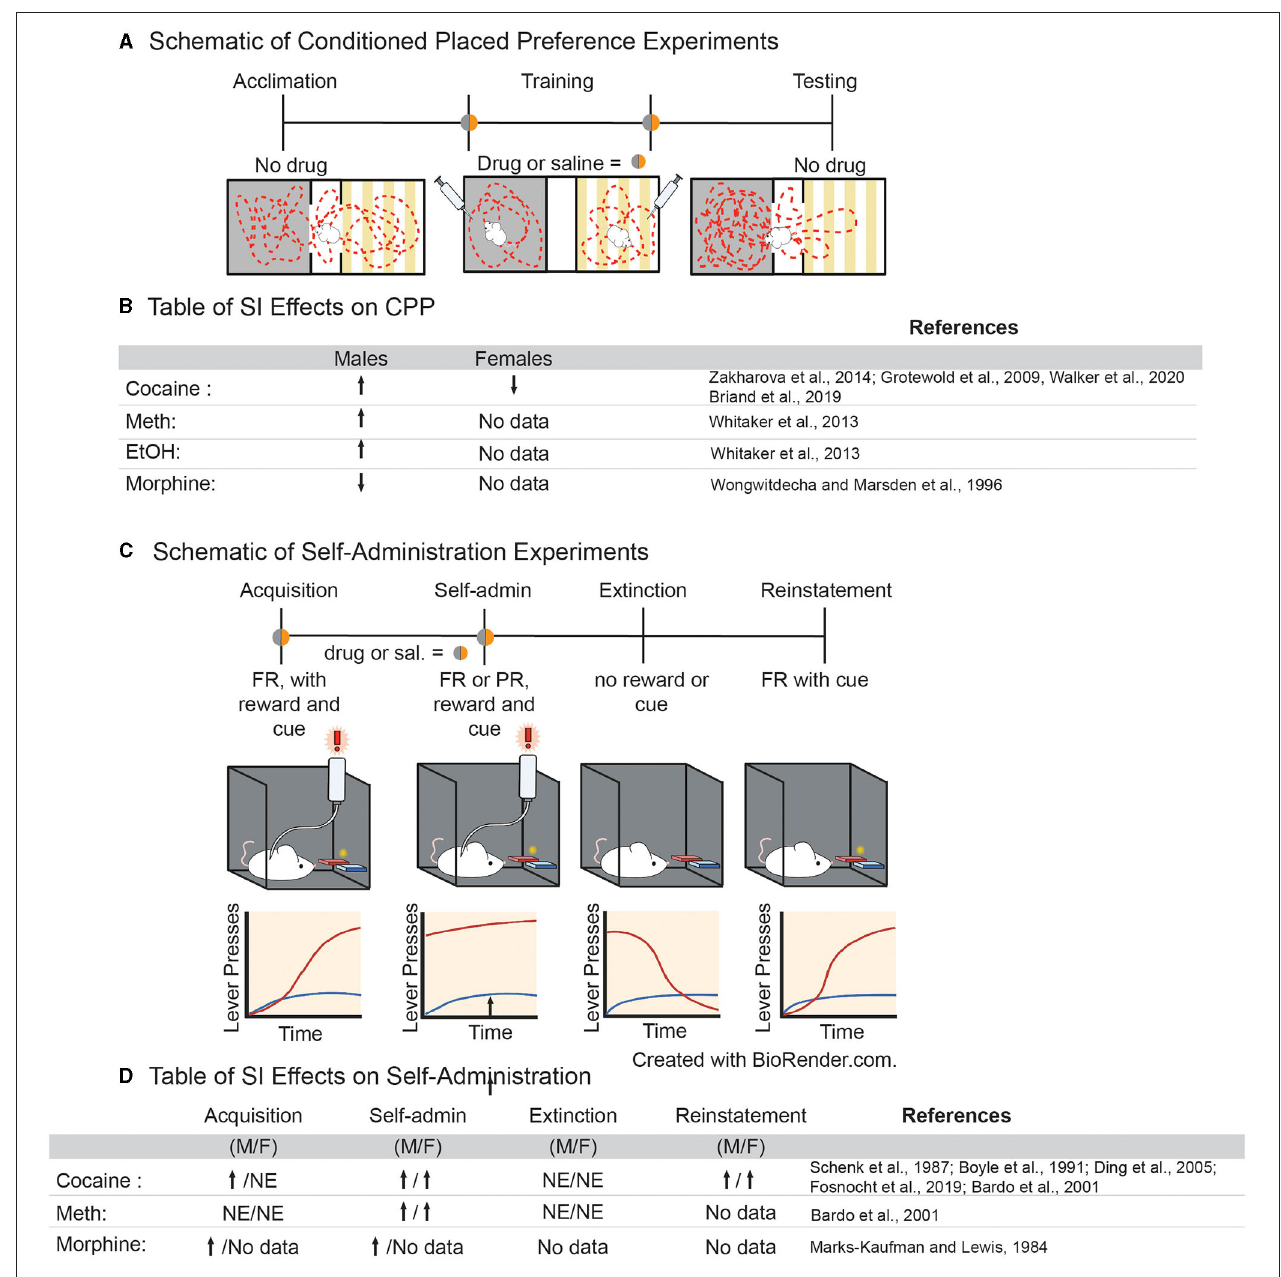
FIGURE 2 | (A) Schematic of experimental approach for conditioned place preference paradigms. (B) Table of effects of adolescent social isolation/ isolation rearing on CPP behavior in males and females. (C) Schematic of experimental approach for volitional self-administration for drugs of abuse in rodents. (D) Table of effects of adolescent social isolation on different aspects of self-administration in males and